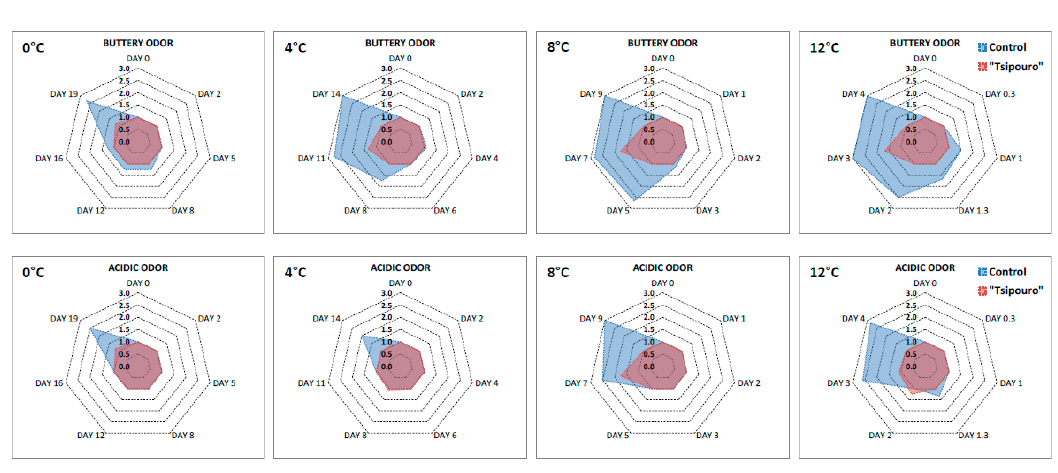
Figure 6. Mean results of buttery and acidic odour of ground beef packaged with absorbent pads supplemented with a total volume of 50 mL “ tsipouro ” (40 mL under the ground beef piece and 10 mL under the labelling, facing the headspace) under 80% O 2 : 20% CO 2 during isothermal storage at 0, 4, 8, and 12 °C. Untreated samples served as controls. The hedonic scale was set from 1 to 3 with 0.5 intervals. Score of 2 was the rejection threshold.